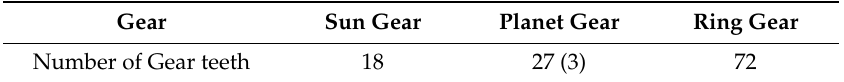
Table 3. Configuration of the planetary gearbox.